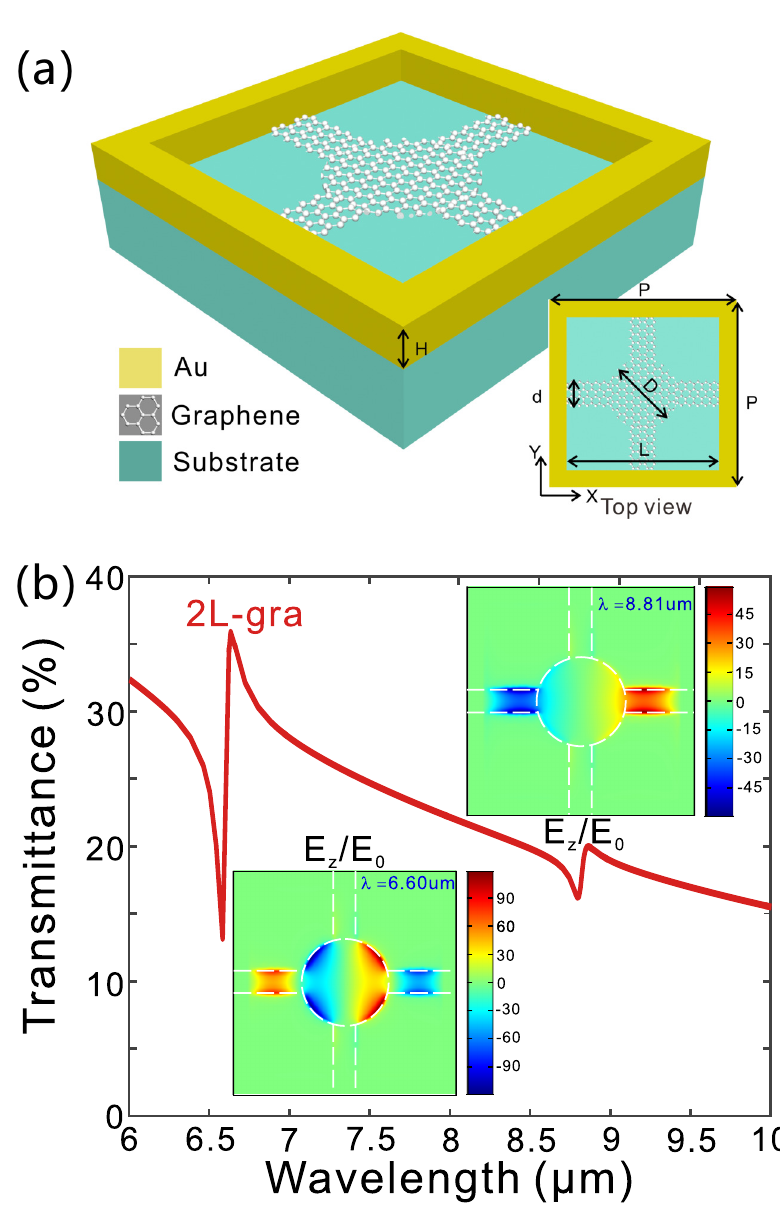
Figure 4. ( a ) Schematic of a modified hybrid metal-graphene metamaterial. ( b ) Simulated spectra of transmission. The insets are field distributions at the two resonances which are normalized to the field amplitude of the incident wave ( E 0 ) and plotted at the x-y plane that is 5 nm below the graphene